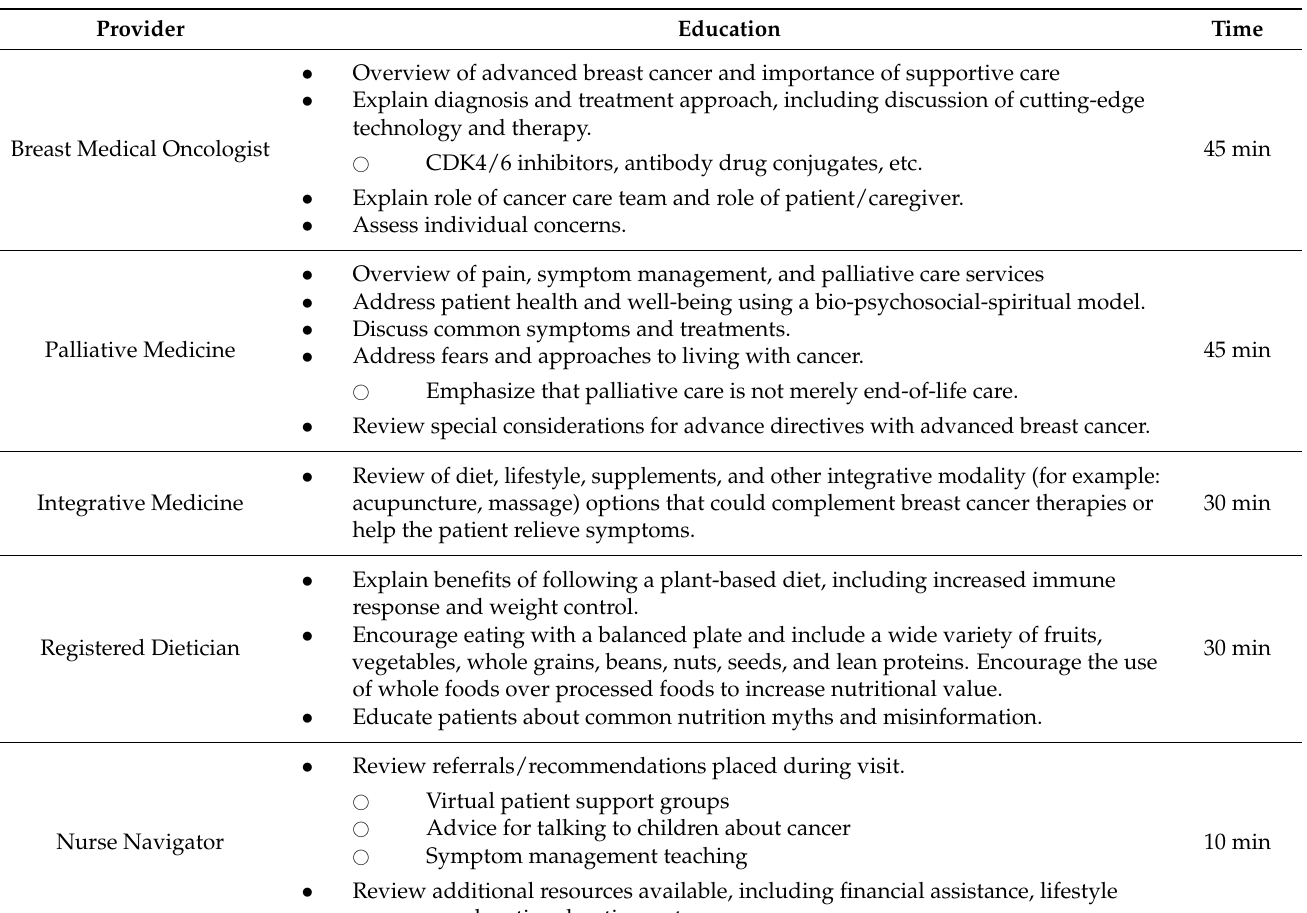
Table 2. The LWABC clinic is broken into five sections, each addressing a different aspect of ABC and focused on overall